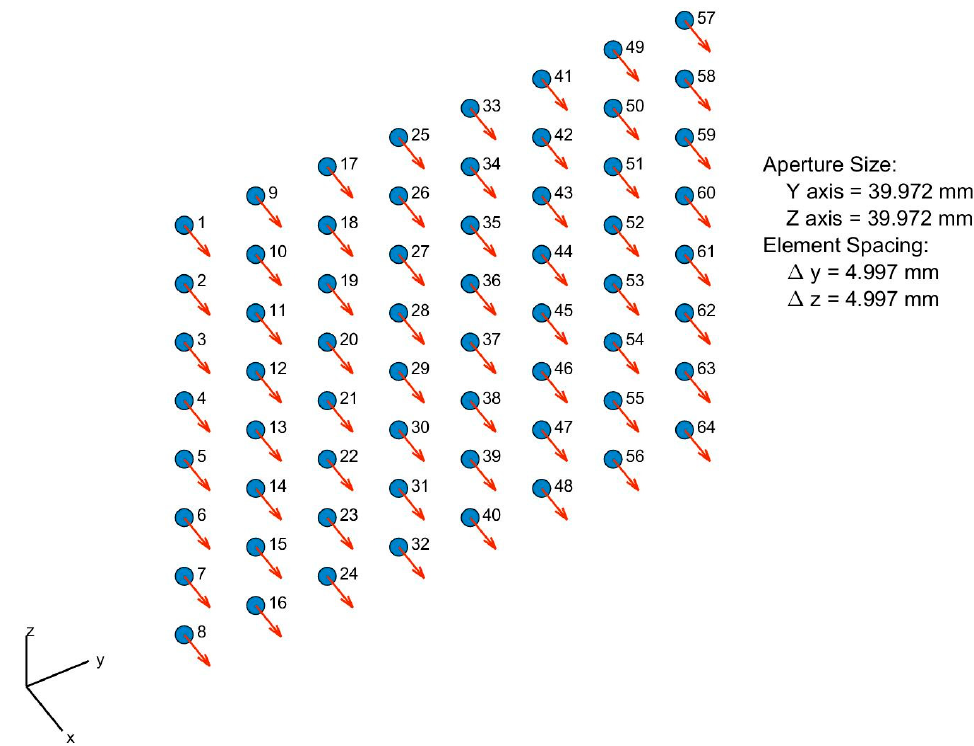
Figure 5. An 8-by-8 uniform rectangular array.